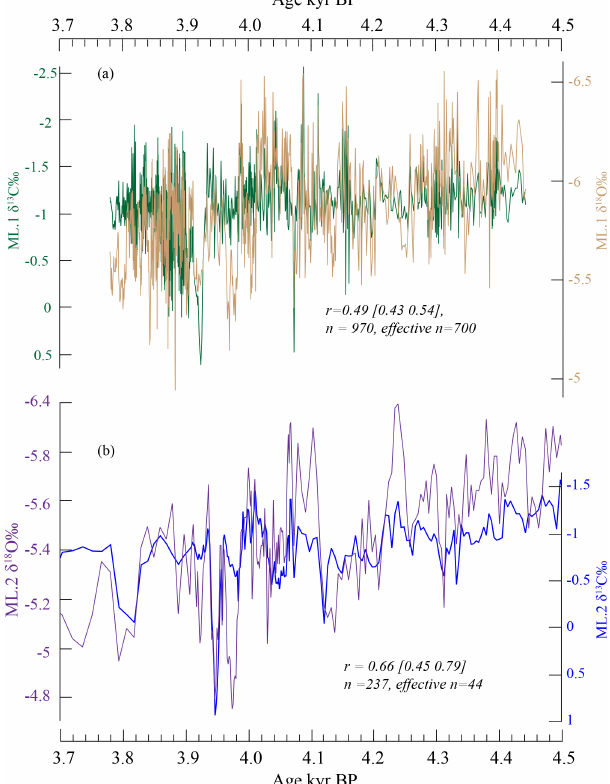
Figure 6. The δ 18 O and δ 13 C profiles of ML.1 and ML.2. (a) The ML.1 δ 18 O (orange) and δ 13 C (green). (b) The ML.2 δ 18 O (pur- ple) and δ 13 C (blue) on their independent age models. The Pearson correlation ( r ) and its 95% confidence interval together with actual and effective sample size (after considering autocorrelation in each profile) are shown in the